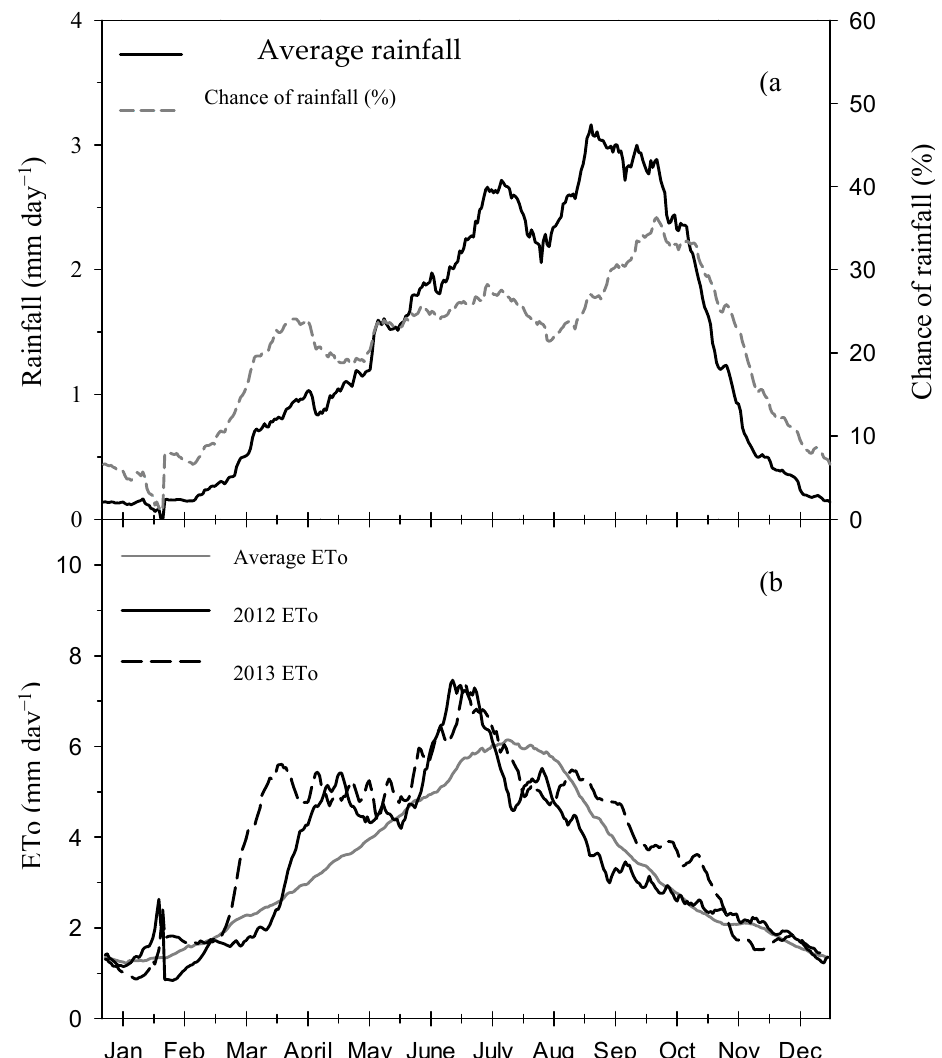
Figure 1. Precipitation and evapotranspiration (ETo) at Yangling, Shaanxi, China. To eliminate extreme variations, daily values are averaged over the previous 30 days. ( a ) 24-year average daily rainfall and percentage chance of rain falling on that day, both expressed as 30-day running average. ( b ) 17-year average ETo also expressed as a 30-day running average, overlaid with 2012 and